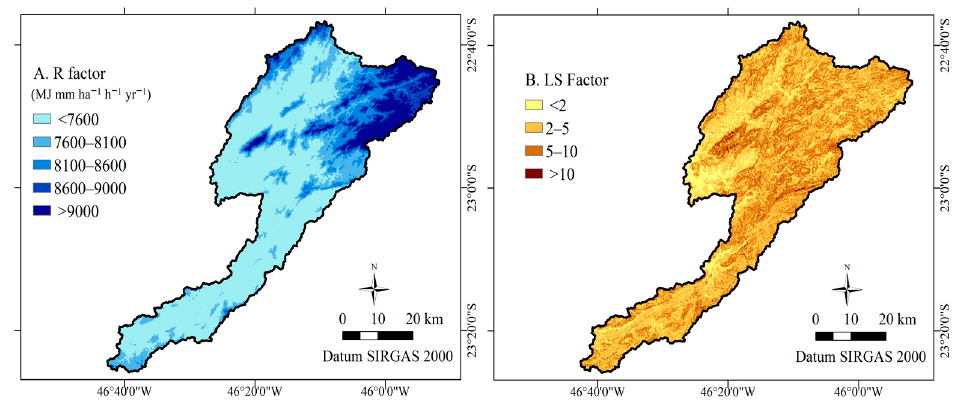
Figure 4. Map of the spatial distribution of the rainfall erosivity factor—R ( A ) and the topographic factor—LS ( B ) in the Cantareira System, Brazil. Note: factor LS = dimensionless. The geographic coordinate system is UTM Sirgas 2000. The basemap is available on ArcMap v. 10.5.